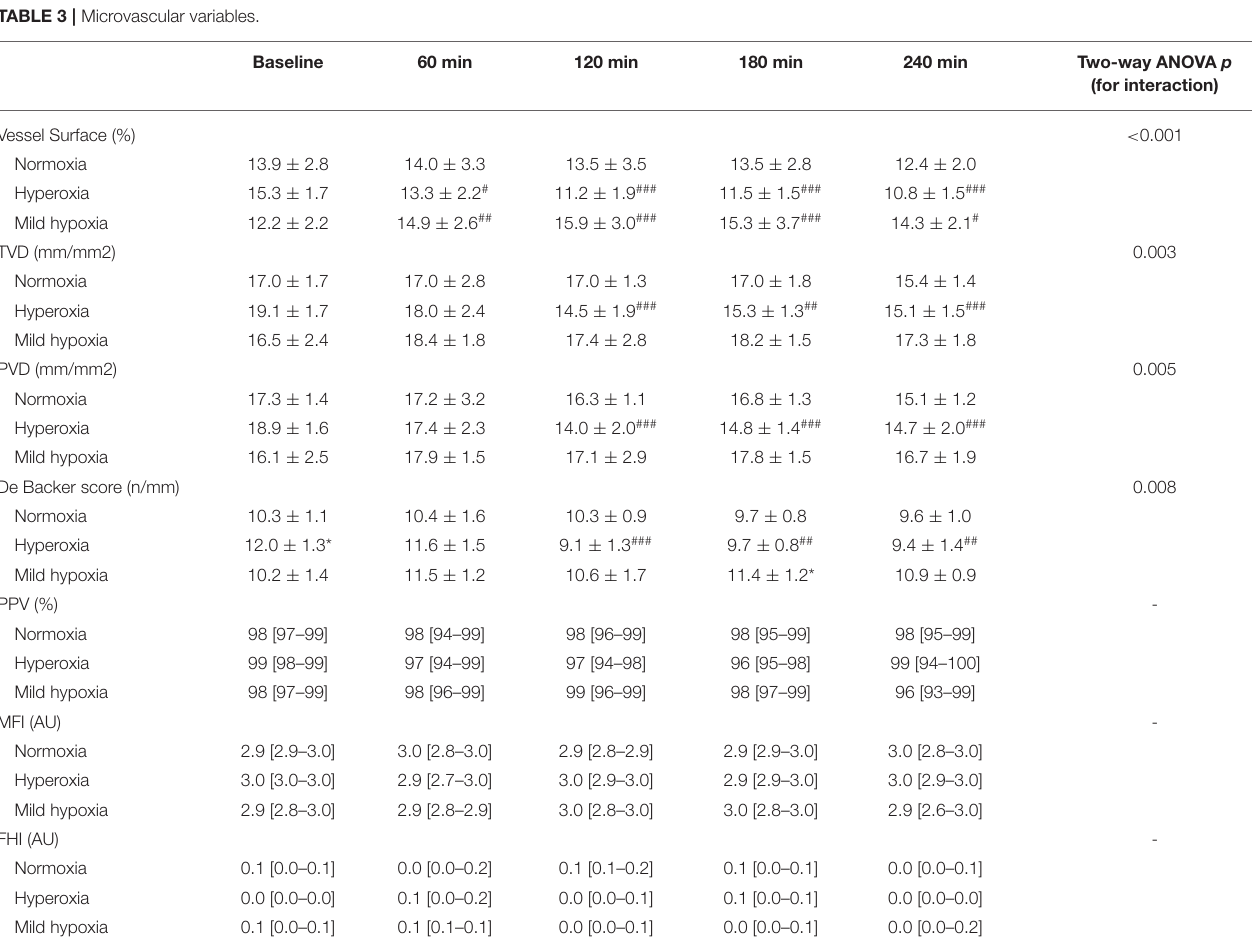
TABLE 3 | Microvascular